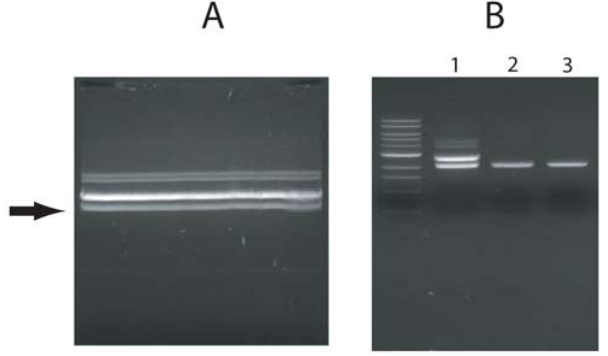
Figure 5. DNA purification from agarose gel. Digested plasmid was fractionated in an agarose gel (A) and a specific band (arrow) cut from the gel. The gel was divided in two and DNA from half was purified by four Qiagen gel extraction columns (2 in B) and the DNA from the other half was purified by a single glass syringe filter (3 in B). The original digestion mixture before purification is included (1 in B). The purified bands were analyzed on a 0.8% TAE agarose gel.